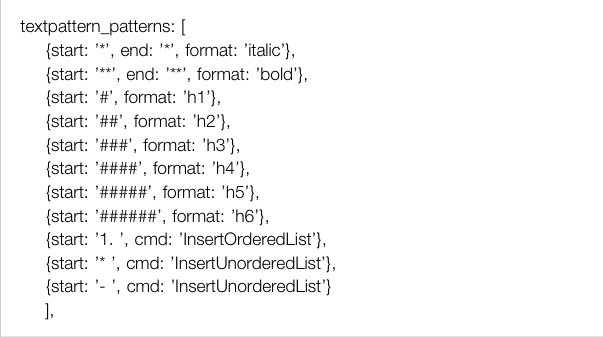
Frontiers in Genetics |